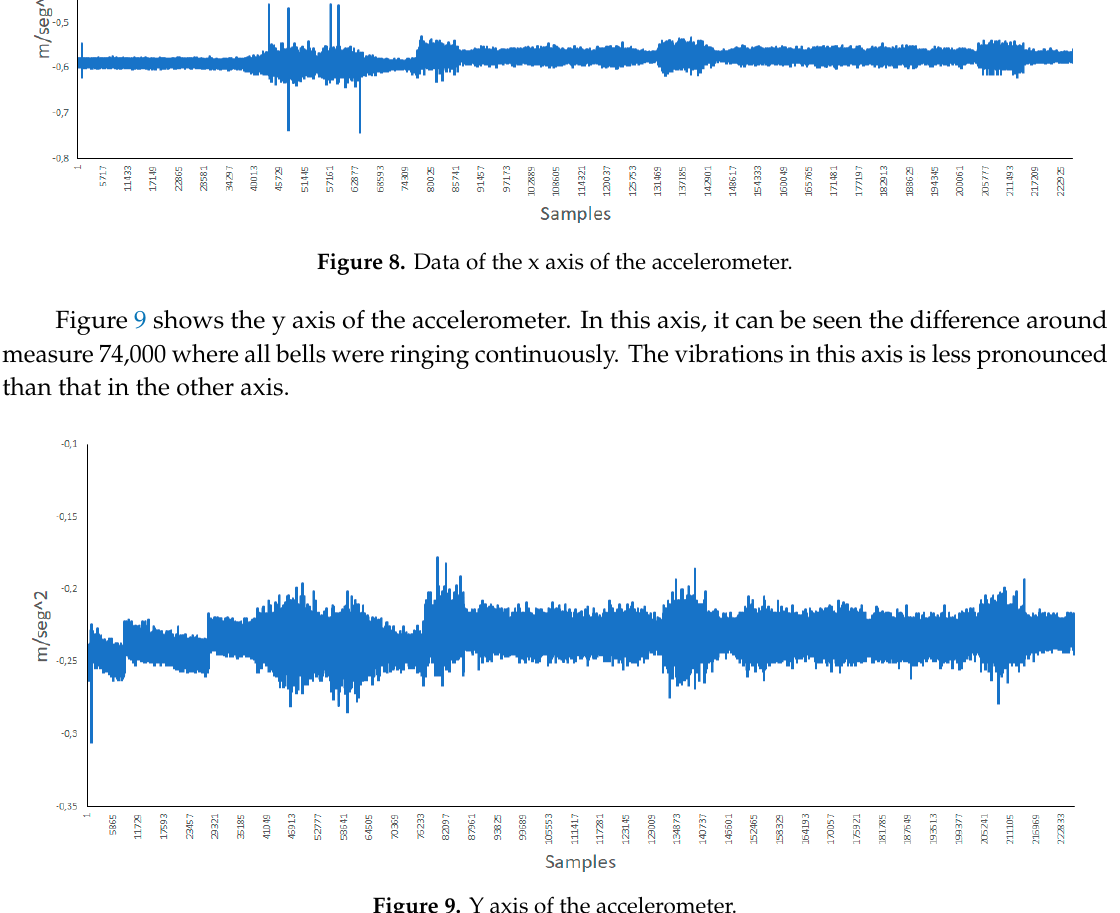
Figure 9. Y axis of the accelerometer.